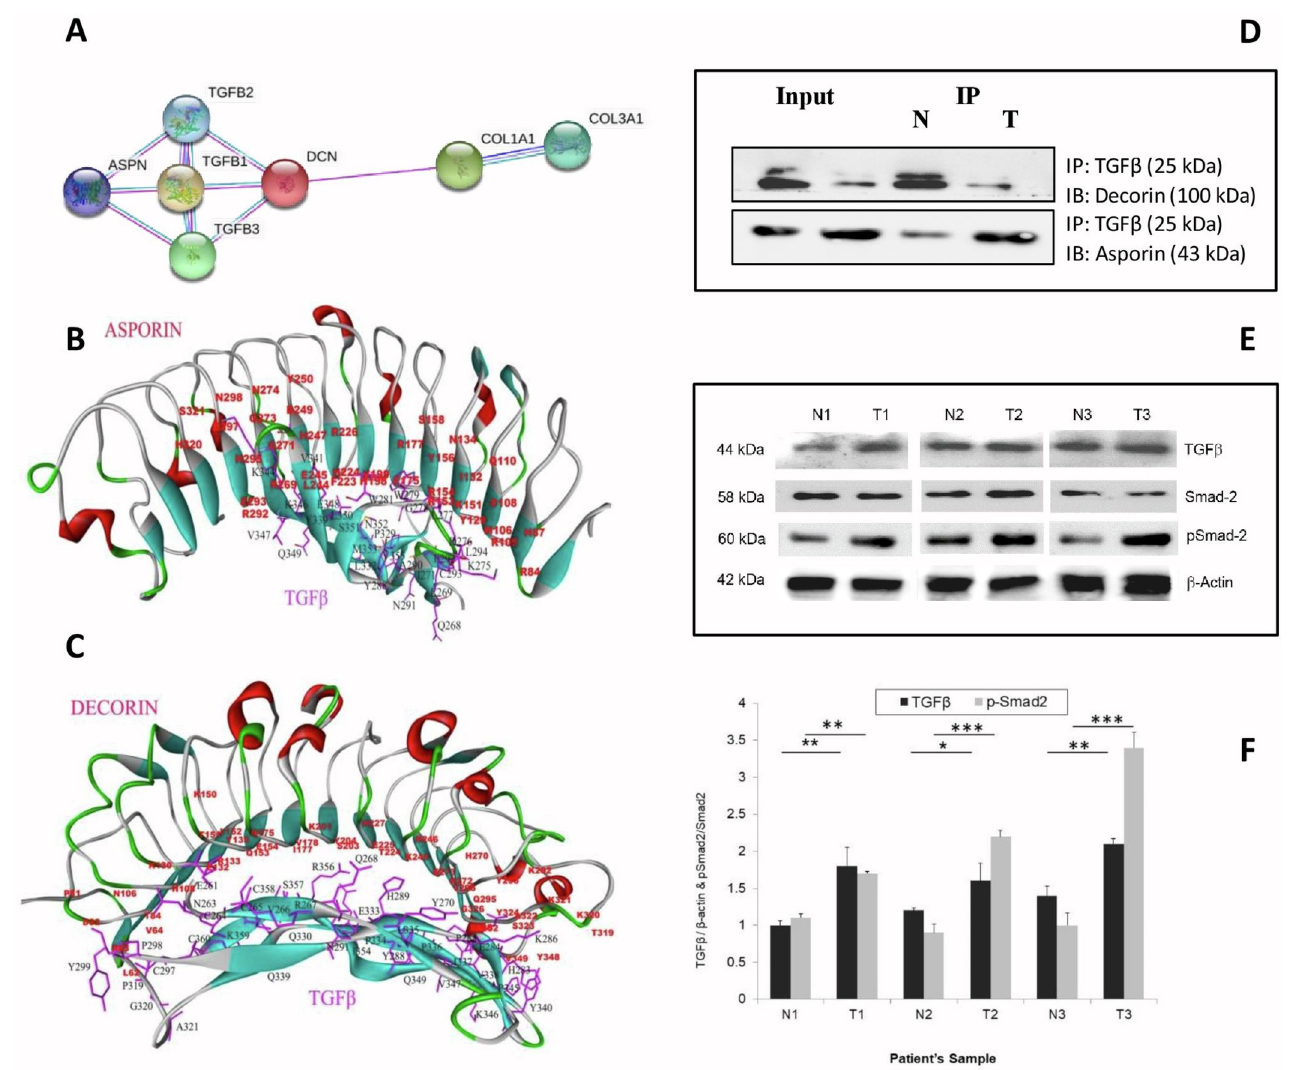
Fig 5. In silico protein-protein interaction analysis. (A) String Interaction Analysis In silico interaction analysis by String (https://string-db.org/) suggests putative interaction of ASPN and DCN with TGF β . The protein is represented by a node, and the interaction between paired proteins is represented by an undirected line. (B, C) Patchdock Interaction Analysis: Interaction between TGF β with ASPN (B) and DCN (C) The interacting residues were shown in figures for ASPN-TGF β complex and DCN-TGF β complex respectively, depicting proper binding pose and predicted amino acids were present in the interface area. Amino acid residues from TGF β are in black font, ASPN and DCN residues are in red font. (D) Co-immunoprecipitation of ASPN and DCN with TGF β : The co-IP assay revealed an association between ASPN, DCN with TGF β in gastric tumor and adjacent normal tissues. (E, F) Expression of TGF β , SMAD2, p- SMAD2 in Gastric adjacent normal and tumor samples analyzed using western blot assay. T1, T2, T3 are tumor tissues and N1, N2, and N3 are respective corresponding normal tissues. Data were quantified, normalized and plotted (n = 3, mean ± SD, � p � 0.05, �� p � 0.01, ��� p � 0.001, student’s t- test).